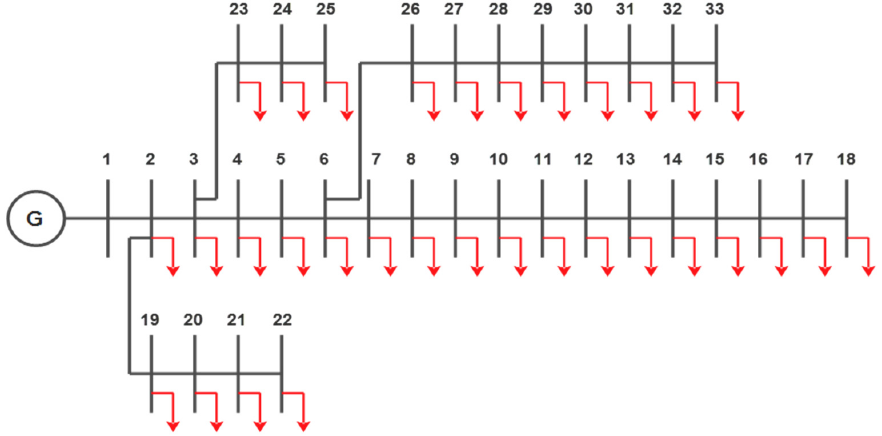
Figure 3. Single-line diagram of a 33-bus